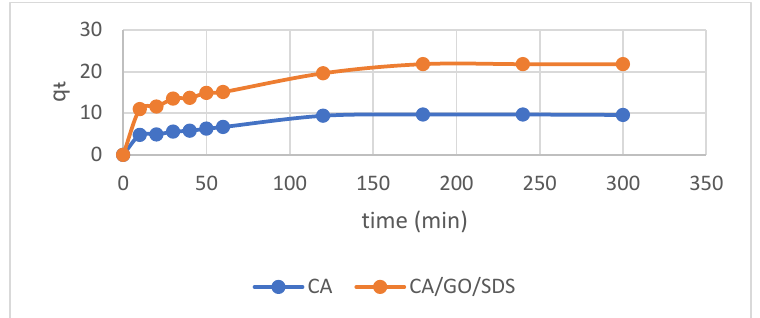
Figure 4. The adsorption time for phosphate removal from the aqueous solution.